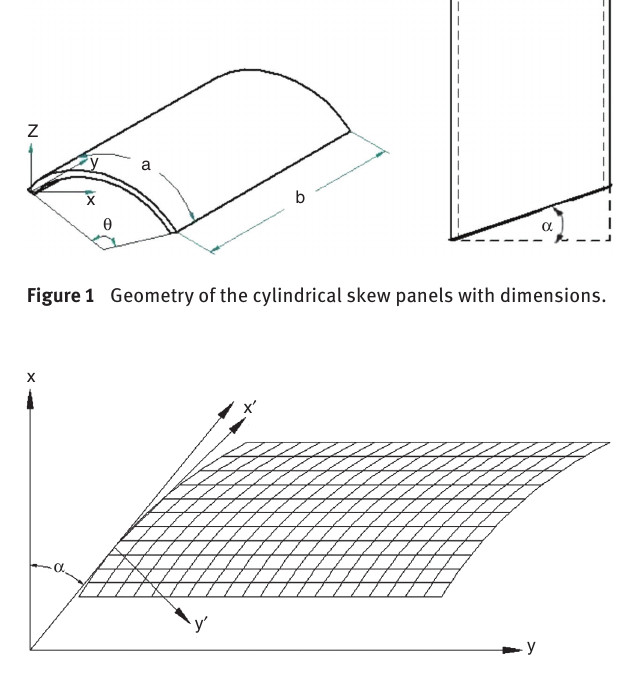
Figure 2 Global and local coordinate systems for cylindrical skew panel used in finite element analysis.